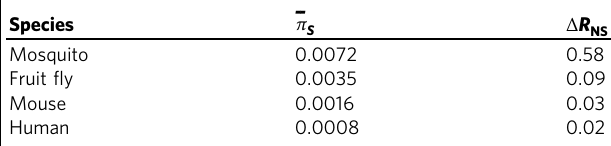
Table 1 The proportional change in the relative fi xation rate of nonsynonymous mutations in early vs. late genes, Δ R positively correlated with average diversity at synonymous -- π , across the four species. sites, S